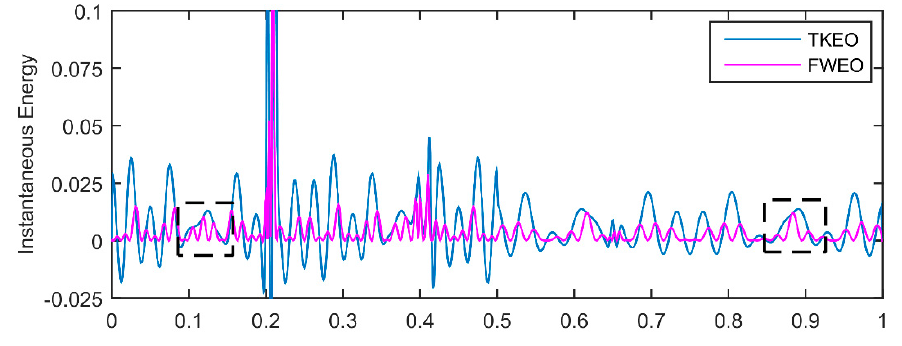
Figure 3. Instantaneous energy of the synthetic signal.